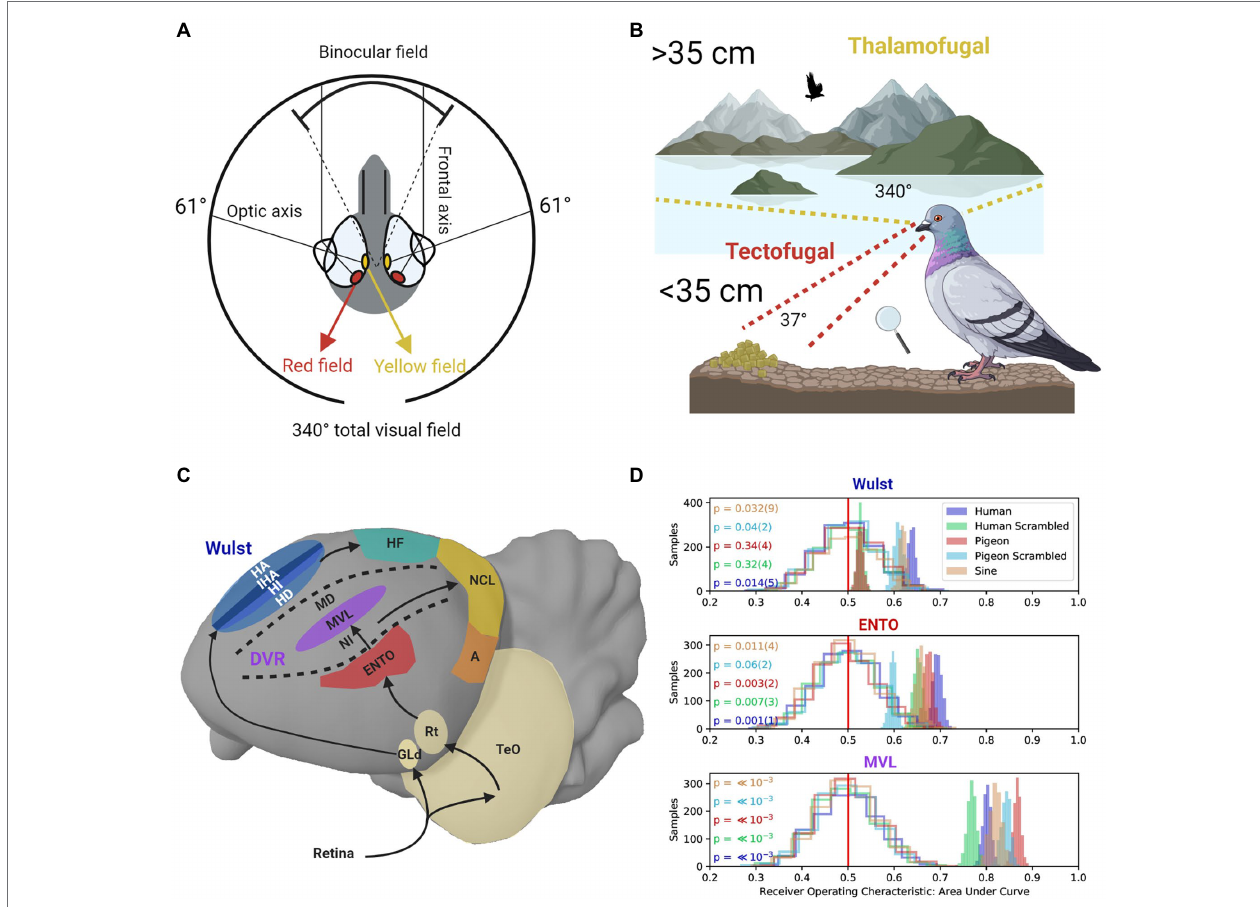
FIGURE 1 | (A) The pigeon eye has two fovea regions that are located close to the optic axes. The yellow field is mainly used to view distant objects in the monocular lateral visual field. The red field is mainly used to view nearby objects. The frontal axes converge during viewing of nearby objects, producing a field of binocular overlap. (B) Frontal viewing of nearby objects using the red field is mainly performed using the tectofugal pathway (red lines). Lateral viewing of distant objects using the yellow field is mainly performed using the thalamofugal pathway (yellow lines). (C) Sagittal depiction of visual information flow in the tectofugal pathway (Red, Purple) layers of the DVR to NCL (Yellow), and thalamofugal pathway layers (Blue) to HF (Green). GLd, dorsolateral geniculate nucleus; HA, hyperpallium apicale; IHA, interstitial nucleus of the hyperpallium apiciale; HI, hyperpallium intercalatum; HD, hyperstriatum dorsale; HF, hippocampal formation; TeO, optic tectum; Rt, nucleus rotundas; ENTO, entopallium; NI, intermediate nidopallium; MVL mesopallium ventrolaterale; MD, mesopallium dorsale; NCL, nidopallium caudolaterale; A, arcopallium; DVR, dorsal ventricular ridge. (D) Single-unit recordings during frontal viewing of images determined that MVL of the tectofugal pathway discriminates between different images with high capacity, in contrast with ENTO and the Wust (Clark et al., 2022). The unfilled distributions show the performance of a linear discriminant analysis trained on randomly labeled firing rate data, which contain “no information” for the permutation significance test. The shaded distributions show the performance of correctly labeled data. p values (and their error) are shown to the left for each group of stimuli viewed by the pigeons (color coded on the left). The value of p for each stimulus group is derived from how far away from the “no information” distribution of samples that the correctly labeled performance